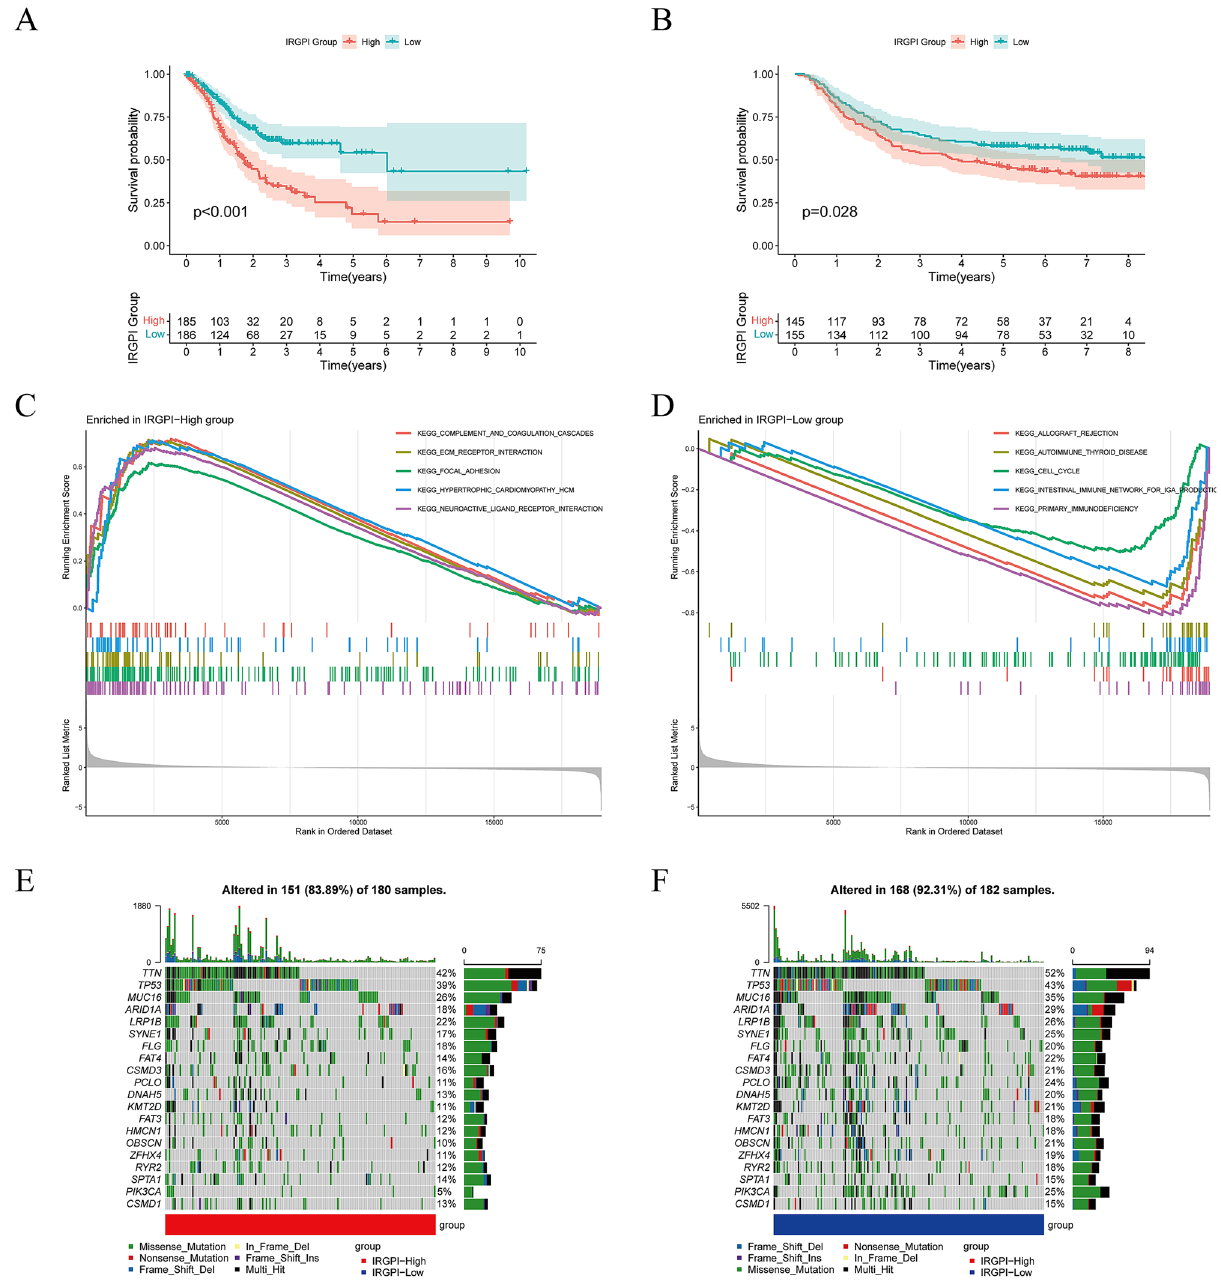
Figure 3. Prognostic analysis and molecular characteristics of different IRGPI groups. ( A ) Kaplan–Meier survival analysis of the IRGPI groups in the TCGA cohort. ( B ) Kaplan–Meier survival analysis of the IRGPI groups in the GEO cohort. ( C ) Gene sets enriched in IRGPI-High group in TCGA-STAD cohort. ( D ) Gene sets enriched in IRGPI-Low group in TCGA-STAD cohort. ( E ) Gene mutation landscape in IRGPI-High group in TCGA-STAD cohort. ( F ) Gene mutation landscape in IRGPI-Low group in TCGA-STAD cohort. [Figures created by R, version IRGPI and clinical characteristics (Fig S2). We found that patients with gastric cancer (age ≤ 65) had higher risk score. In addition, there was no statistically significant difference between IRGPI and tumor stage. Survival outcomes and molecular characterization of different IRGPI groups. Patients with IRGPI-low had superior OS than those with IRGPI-high (p < 0.001, log-rank test) when the median IRGPI was used as the threshold value in the TCGA-STAD cohort (Fig. 3A). Moreover, we performed survival analysis on the GSE62254 (n = 300) GC dataset to assess the generality of IRGPI in prognosis. Equally, patients in the IRGPI- low group fared better than those in the high IRGPI group (p = 0.028, log-rank test) (Fig. 3B).